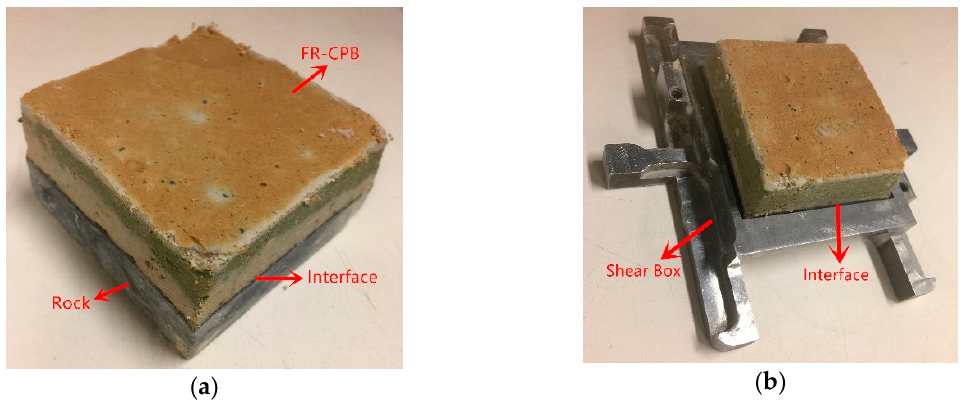
Figure 3. Specimen ( a ) before and ( b ) after being put inside the shear box.